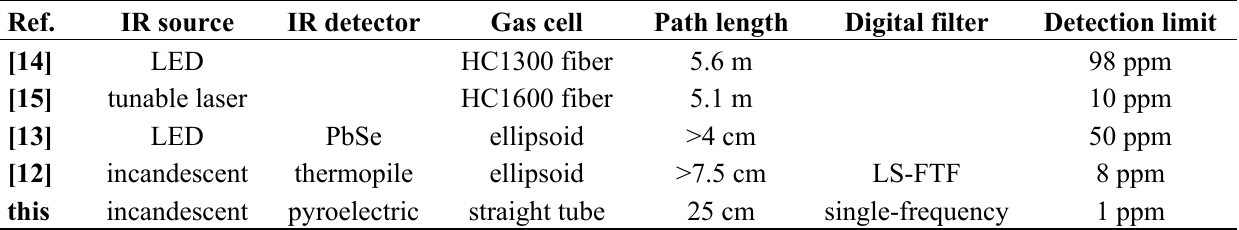
Table 1. Comparison between our methane sensor and some other low ppm methane sensors.